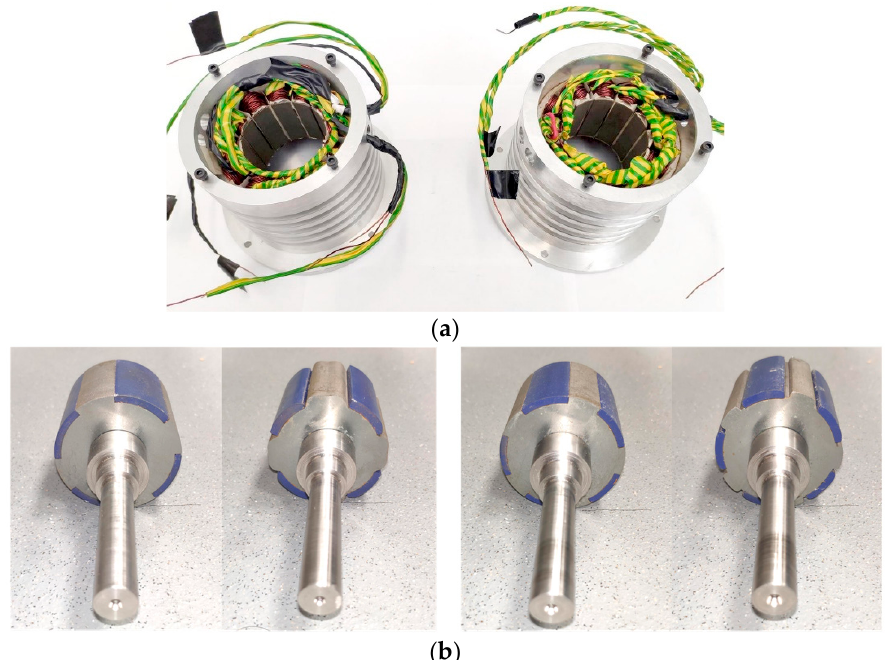
Figure 37. Manufactured prototypes. ( a ) 12s8p (left) and 12s10p (right) stators. ( b ) Rotors (from left to right: 12s8p-CCPPM, 12s8p-PSCPPM, 12s10p-CCPPM, 12s10p-PSCPPM).